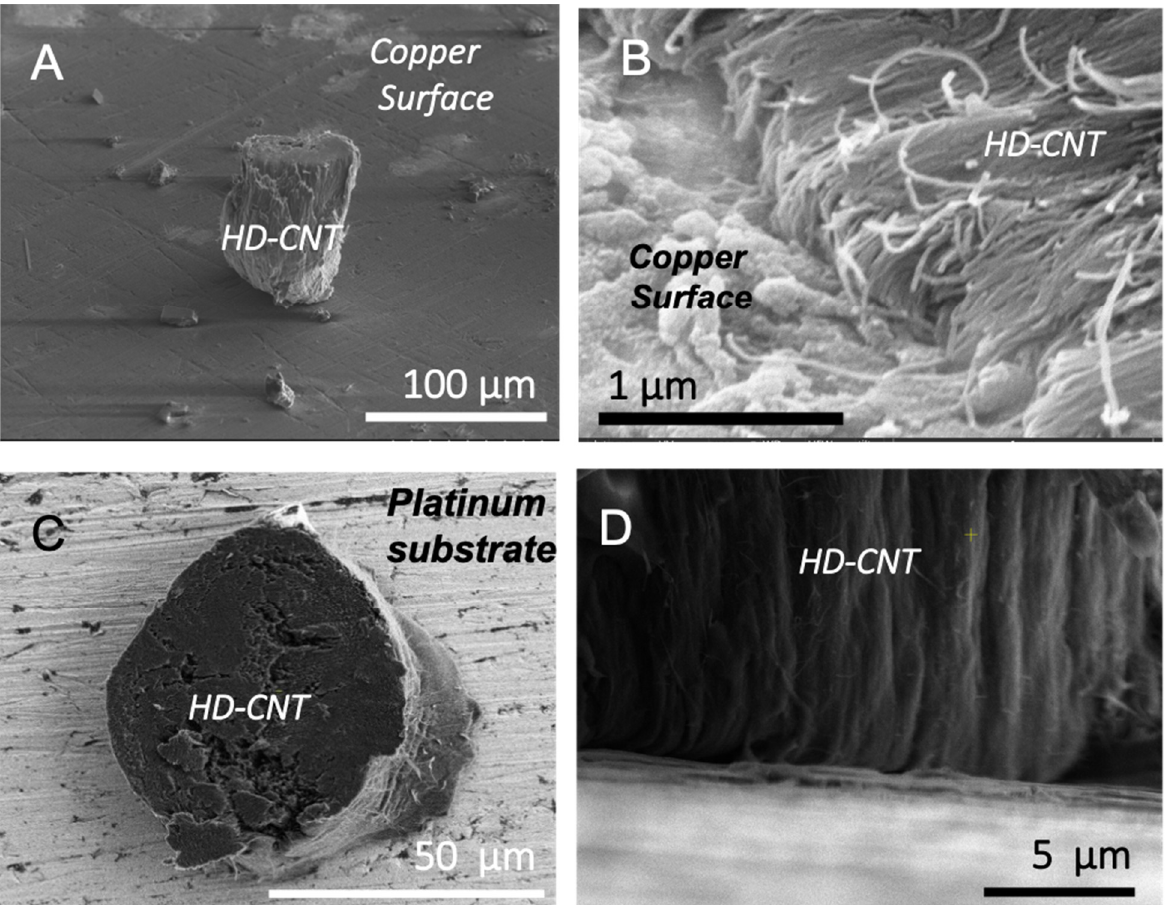
Figure 4. SEM images of HD-CNTs bonded to a solid Cu and Pt surfaces after removing the encapsulating polymer. ( A ) Low-magnification and ( B ) high-magnification images showing the three-dimensional nature of the CNTs assembled on the Cu surface. ( C ) Low magnification and ( D ) high magnification of CNTs connected to the metal Pt surface.